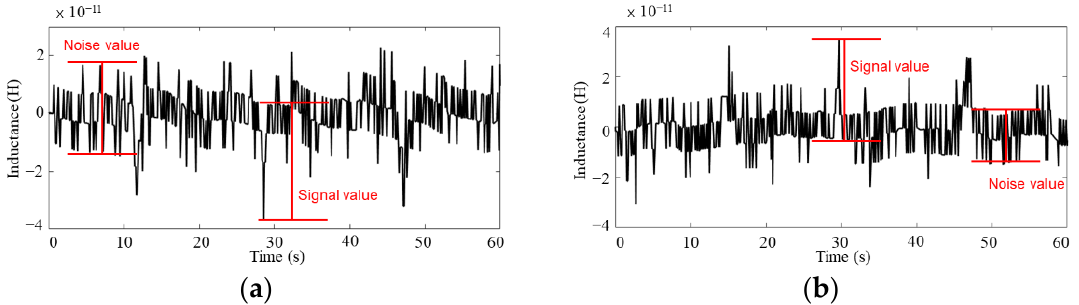
Figure 10. Waveform diagram of metal particle detection with or without permalloy package: ( a ) waveform plots for detecting 10–15 μ m iron particles, ( b ) waveform plots for detecting 65–70 μ m copper particles.